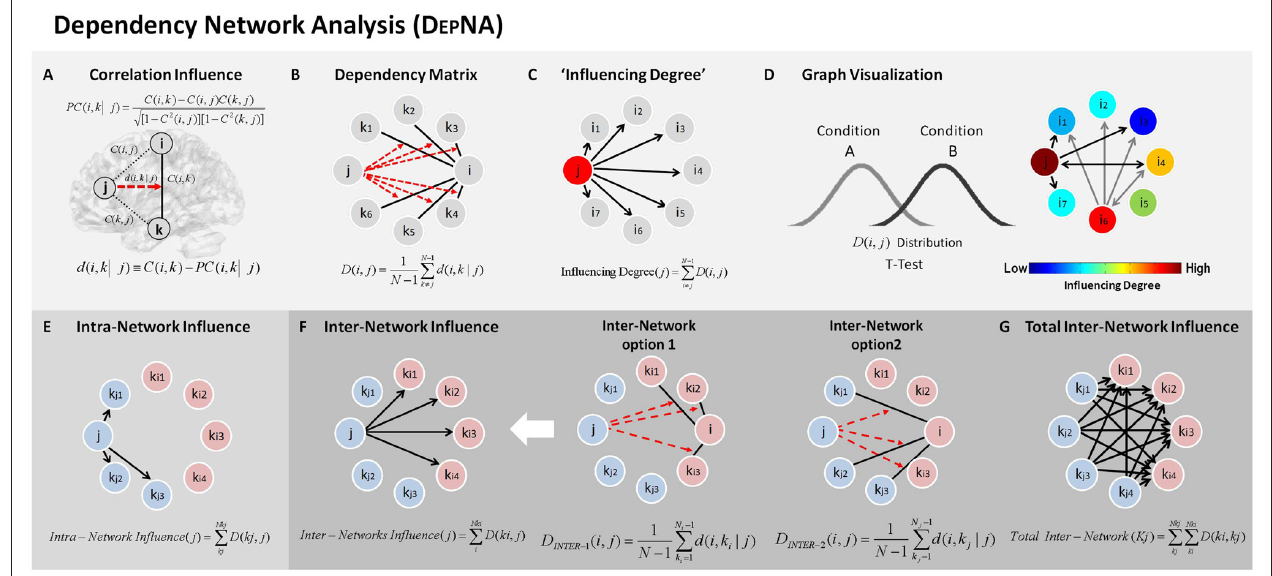
FIGURE 2 | Dependency network analysis (D EP NA). Step 1: (A) Partial correlation coefficient—a statistical measure indicating how a third variable affects the correlation between two other variables. For example the partial correlation between nodes i and k with respect to a third node j —PC( i , k | j ) defined in the equation. Where C( i , k ), C( i , j ) and C( k , j ) are the regions of interest (ROI)-ROI correlations. We then define the influence of j on the pair of elements i and k as the difference between the correlation and the partial correlation. Step 2: (B) Dependency Matrix—Next, we calculate the partial correlation effect for each ROI on all other pairwise correlations in the network. We define the total influence of node j on node i , D( i , j ) as the average influence of node j on the correlations C( i , k ), over all nodes k . The node dependencies define a dependency matrix D, whose ( i , j ) element is the influence of node j on node i . Step 3: (C) “Influencing Degree”—We then define the influences of node j as the sum of the influence D( i , j ) of j on all other nodes i . The higher this measure the more this node influenced all other connections in the network. Step 4: (D) Graph Visualization –Each ROI is color-coded according to its influencing or influenced degrees. All pairwise ROIs with dependency elements D that are significantly different between two conditions (or groups) at the p < 0.05 level are plotted as edges. Each edge is color-coded according to the t -test sign as light or dark gray. The arrows represent the direction of influence. (E) Intra-Network influence—The influence within the sub-network is computed for each node as the sum of its influences on the nodes within its network. (F) Inter-Network influence—The influences between the sub-networks is calculated for two different options: (1) as the sum of the influences of a node from one network only on the connections within the second network; and (2) as the sum of the influences of a node from one network only on the connections between the first ( kj ) and the second ( ki ) networks. (G) Total inter-network—total influences between the sub-networks were computed as the sum of all inter-network influences from one network on the nodes within the second